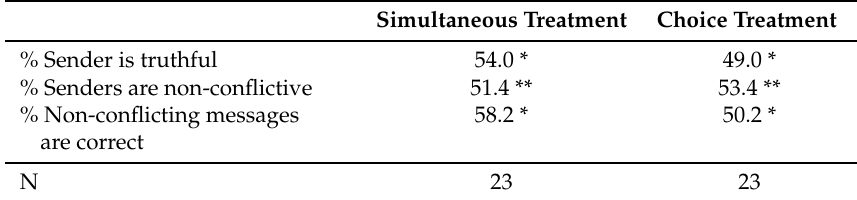
Table 2. Sender Behavior with Simultaneous Message s a